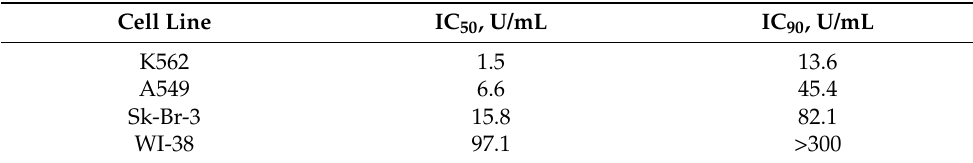
Table 2. IC 50 and IC 90 values of TsA for cancer and normal cell lines. Cell Line IC 50 ,